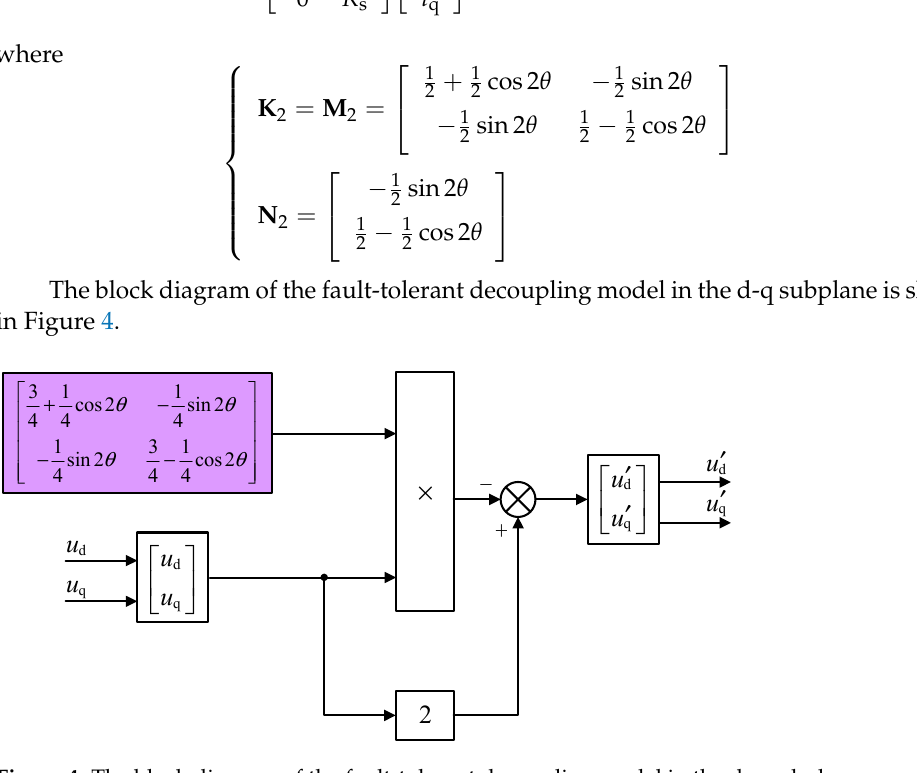
Figure 4. The block diagram of the fault-tolerant decoupling model in the d-q subplane. It can be found that the coefficient matrixes in Equation (9) no longer contains the unknown quantities a and b, which means the Equation (8) does not change with the change of the combination form of these two torque models. Thus, the influence of the